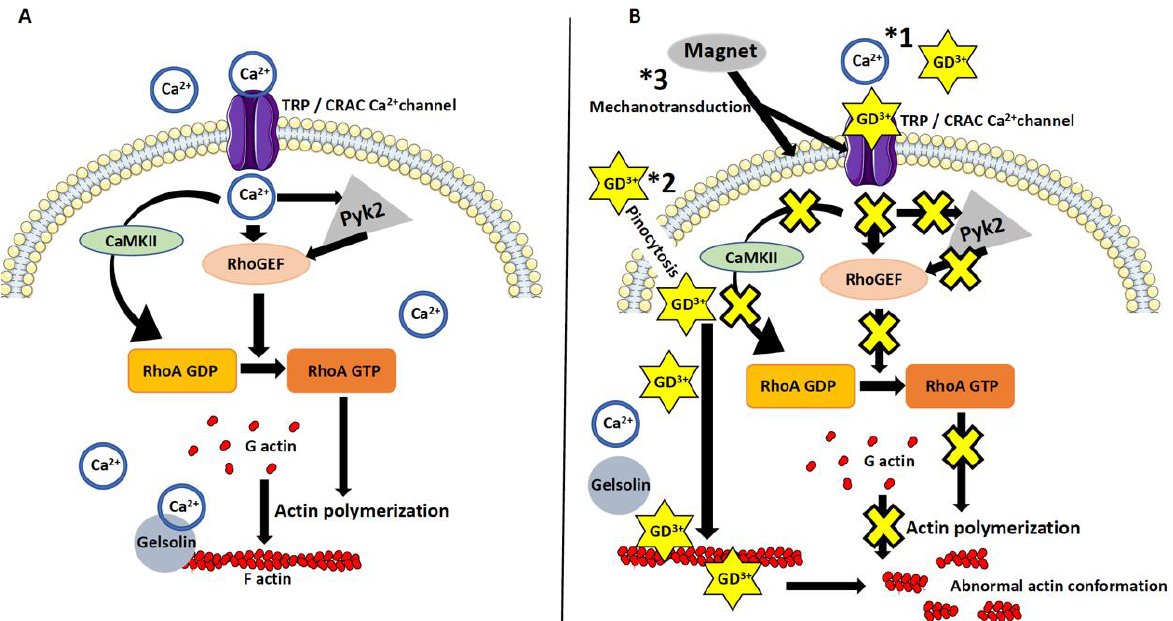
Figure 17. Diagram of the hypothetical effects of gadolinium and the magnetic field gradient on the RhoA pathway and actin dynamics. ( A ) In the untreated cells, calcium influx into the cell and calcium homeostasis were regulated through the TRP/CRAC ion channels. Calcium may regulate GEFs-dependent activation of RhoA through the proline-rich tyrosine kinase 2 (Pyk2) pathway or activate RhoA through the Ca( 2+ )/calmodulin-dependent protein kinase II (CaMKII) pathway. In turn, activated RhoA regulates G/F actin homeostasis and actin polymerization and, thus, all actin-dependent cell func- tions. Actin polymerization may also be affected directly through a calcium-regulated actin filament-capping protein gel- solin. ( B ) Extracellular gadolinium (*1) may block ion-exchange channels and consequently inhibit GEFs and all the down- stream RhoA pathway-dependent processes. Gadolinium may also enter the cell through pinocytosis (*2) and directly affect actin polymerization and homeostasis by preventing binding of calcium to actin and/or gelsolin or directly altering actin filament conformation. The force created by the magnetic field gradient (*3) may, through mechanotransduction, affect ion-exchange channels that, in turn, will disrupt GEFs and RhoA activation and affect all actin-dependent cell func- tions.